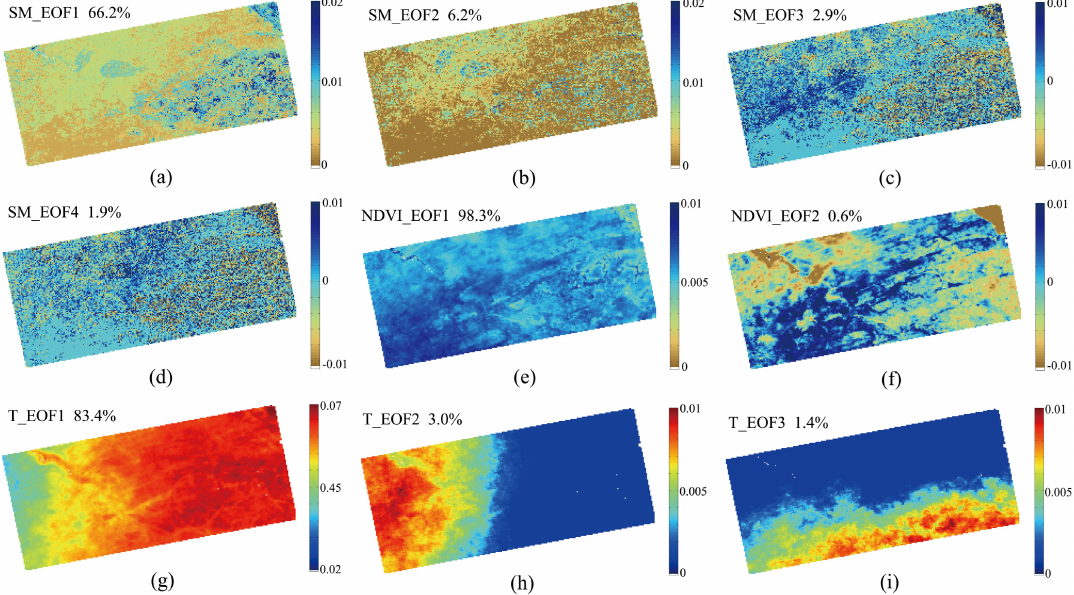
Figure 5. The significant EOFs of S1A_1K, NDVI, and temperature. ( a ) The primary EOF of S1A_1K, with 66.2% of the total variance explained; ( b ) the 2nd EOF of S1A_1K, with 6.2% of the total variance explained; ( c ) the 3rd EOF of S1A_1K, with 2.9% of the total variance explained; ( d ) the 4th EOF of S1A_1K, with 1.9% of the total variance explained; ( e ) the primary EOF of NDVI, with 98.3% of the total variance explained; ( f ) the 2nd EOF of NDVI, with 0.6% of the total variance explained; ( g ) the primary EOF of temperature, with 83.4% of the total variance explained; ( h ) the 2nd EOF of temperature, with 3.0% of the total variance explained; and ( i ) the 3rd EOF of temperature, with 1.4% of the total variance